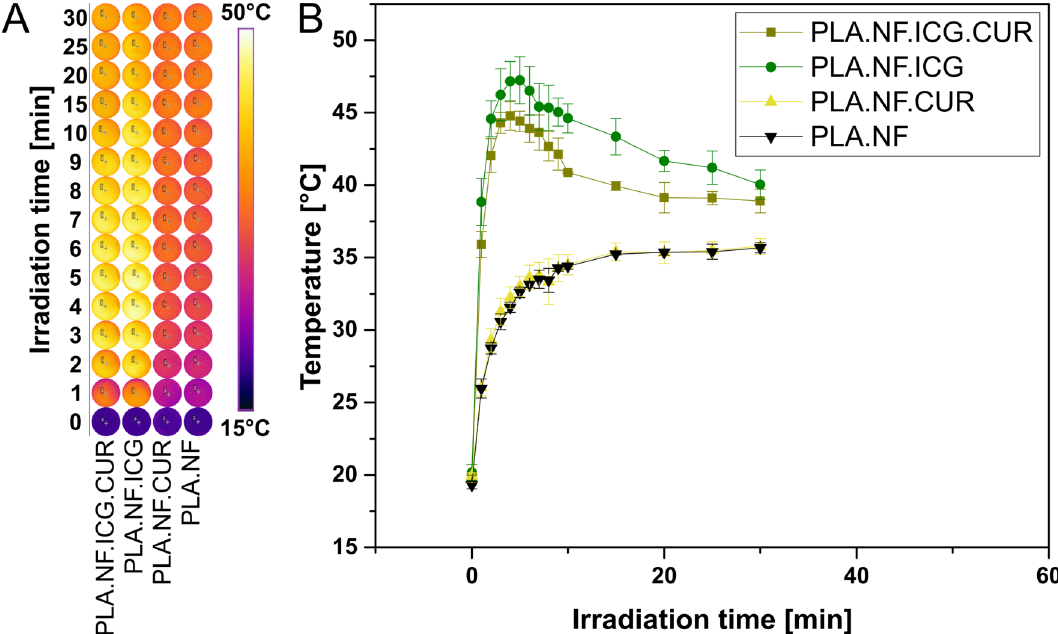
Figure 2. ( A ) Thermal images of each formulation during 30 min irradiation (810 nm) and ( B ) graph- ical representation of the results.